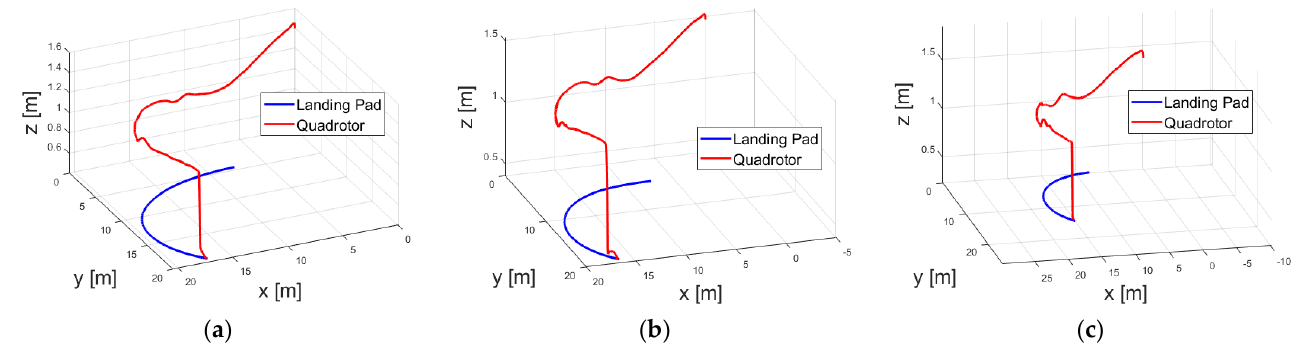
Figure 9. Position of quadrotor and landing pad near the landing point with σ = 0.01.